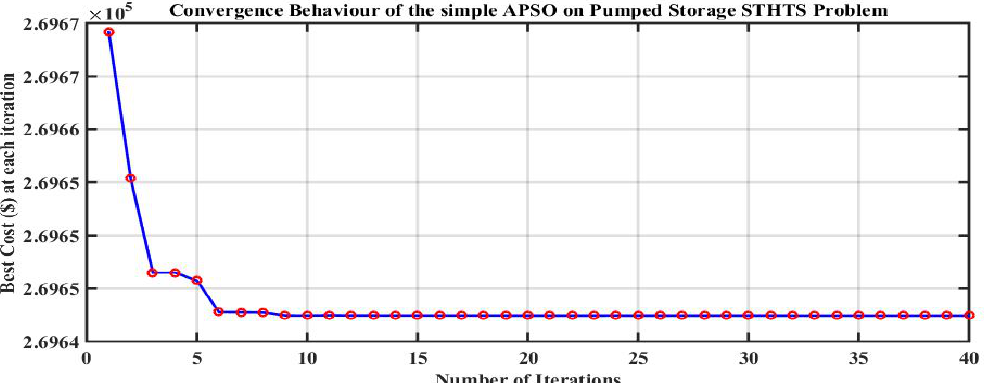
Figure 3. Convergence characteristics of the simple APSO algorithm on the non-cascaded pumped STHTS